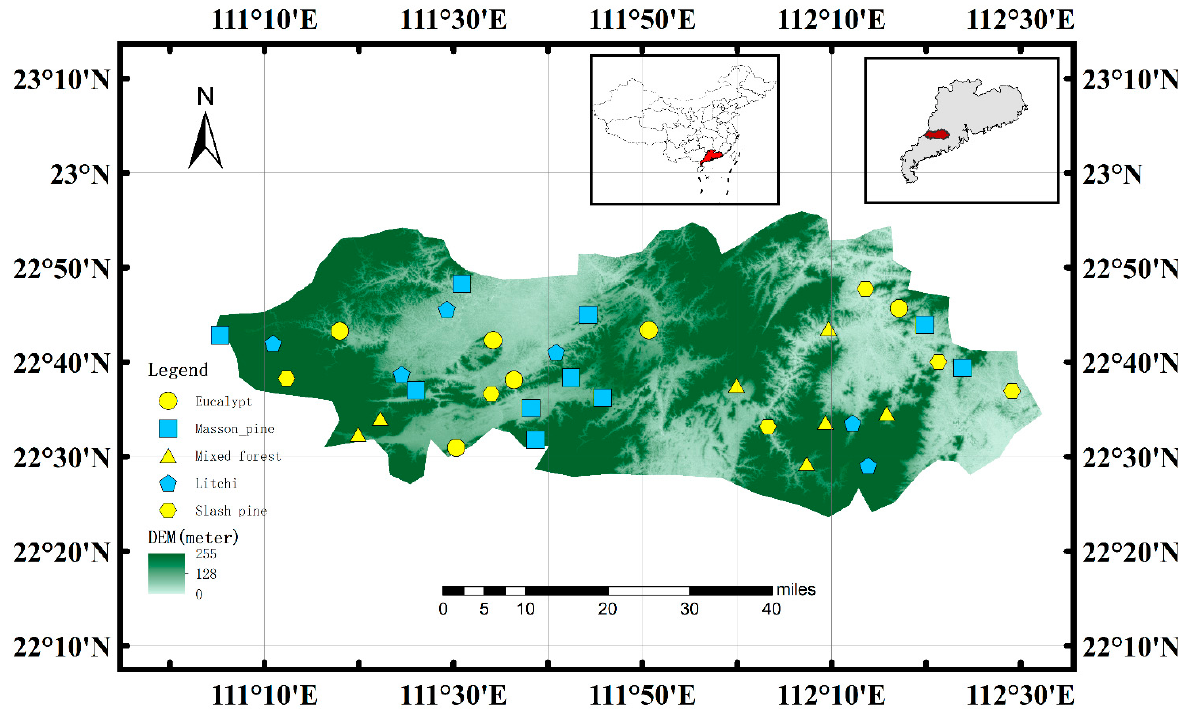
Figure 1. Distribution of stands for soil sampling in forested Ultisols of Yunfu, Guangdong province, South